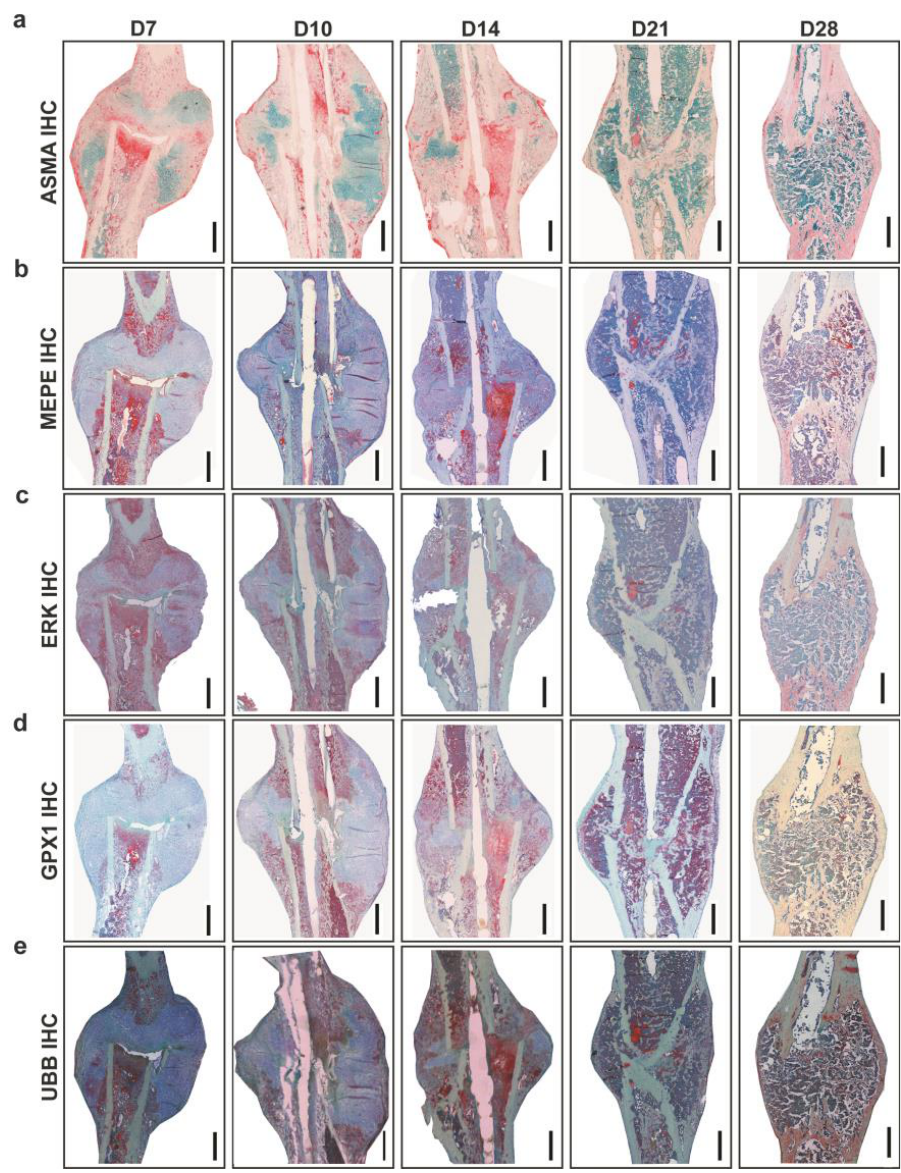
Figure 2. Immunohistochemical stains depict the changes in the fractured callus across the time points of healing. ( a ) ASMA IHC stain helped in the visualization of blood vascularization. ( b ) MEPE IHC, and ( c ) ERK IHC stain helped in the cellular understanding of ECM regulation. ( d ) GPX1 IHC stain was carried out to examine mitochondrial activity at the cellular level. ( e ) UBB IHC stain was carried out to examine ribosomal activity at the cellular level (scale bar: 250 µm).